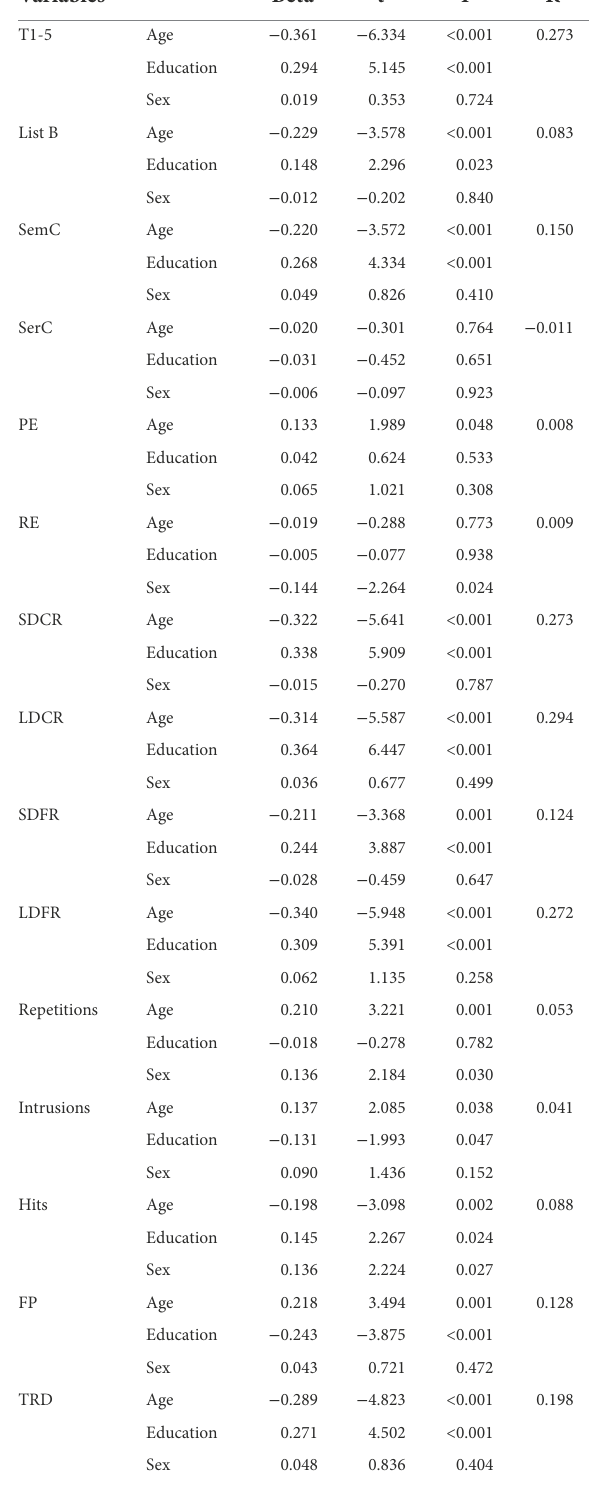
TABLE 5 Inferential statistics associated with linear regression analysis examining effects of age, education and sex on CVLT-II performance.